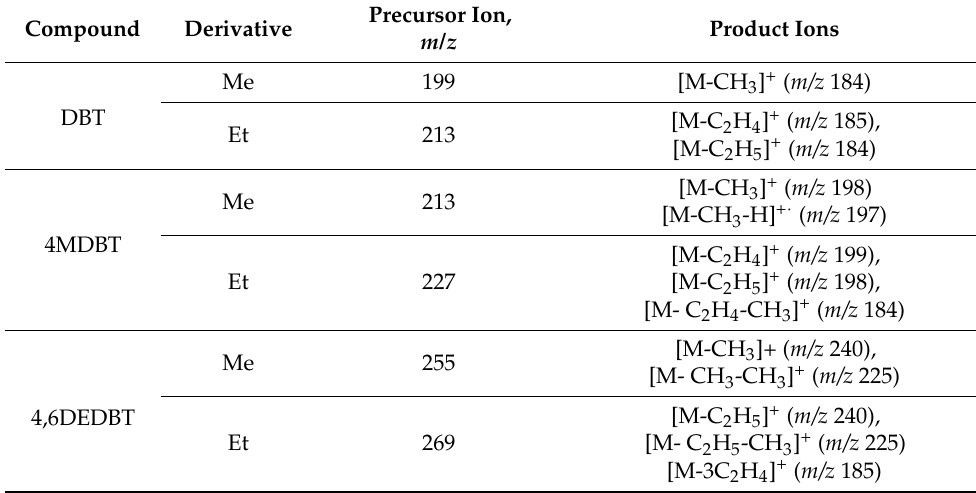
Figure 2. ESI mass spectra of an artificial mixture of dibenzothiophenes derivatized by PDMSO/TfA ( a ) and PDESO/TfA ( b ). Table 1. The detected ions corresponding to cationic parts of the derivatives. Table 2. Precursor and product ions in CID mass spectra (CE 30 eV) of DBT (a), 4MDBT (b) and 46DEDBT